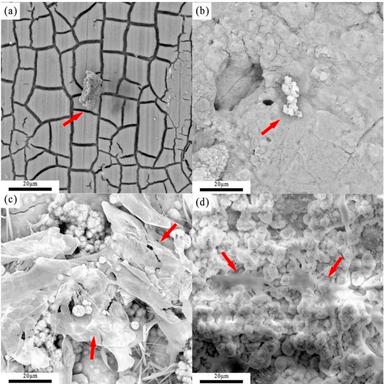
The cell morphologies on the surfaces of (a) ZG11 alloy, (b) the AO sample, (c) the ED sample, (d) the ST sample.